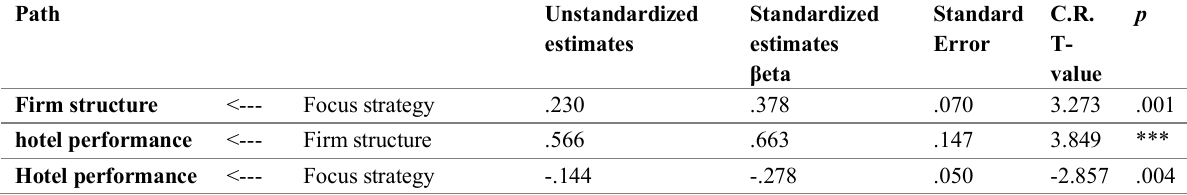
Table 2: Path Coefficients of Influence of Focus Strategy-Firm Structure Fit on Hotel